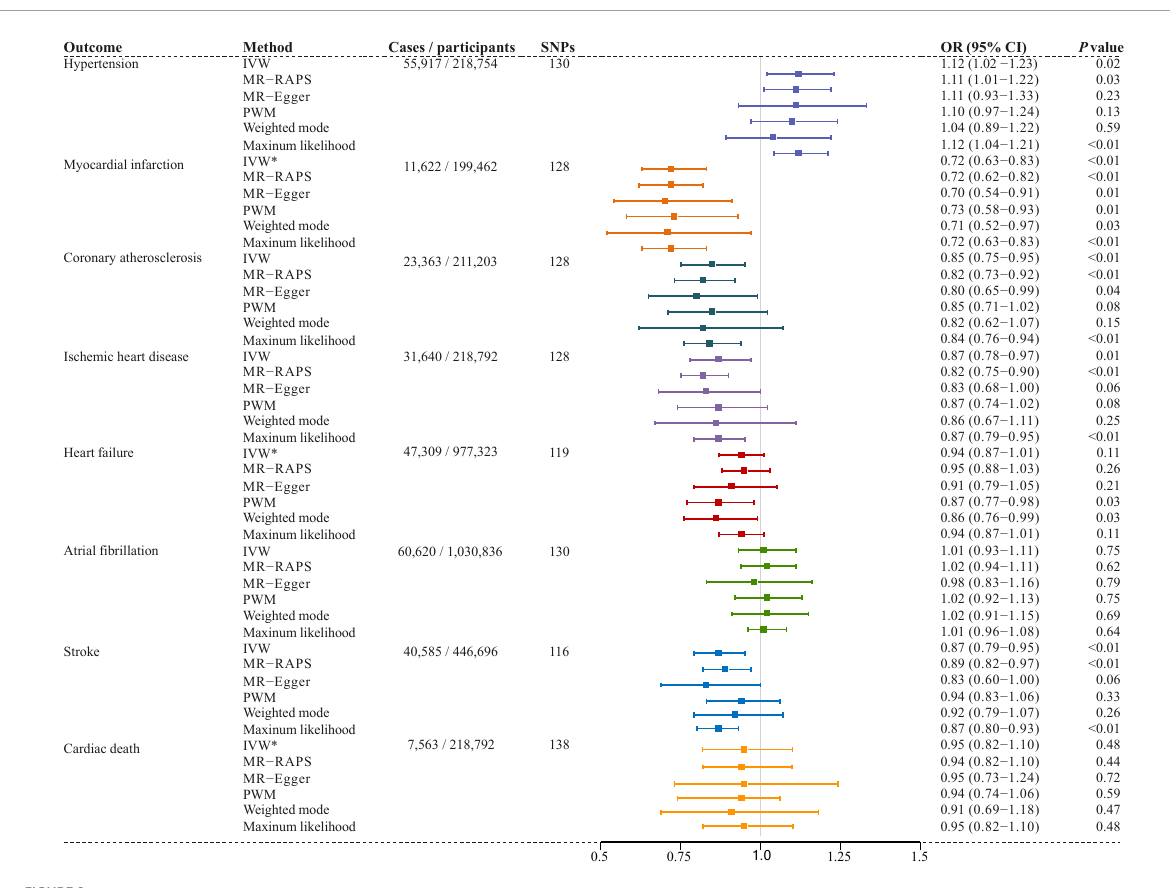
FIGURE2 Associations of genetically predicted telomere length (TL) and the risk of cardiovascular diseases (CVDs). SNPs, single nucleotide polymorphisms; IVW, inverse variance weighted (random-effects model); IVW*, inverse variance weighted (fixed-effects model); MR-RAPS, Mendelian randomization robust adjusted profile score; MR-Egger, Mendelian randomization-Egger; PWM, penalized weighted median; OR, odds ratio; CI, confidence